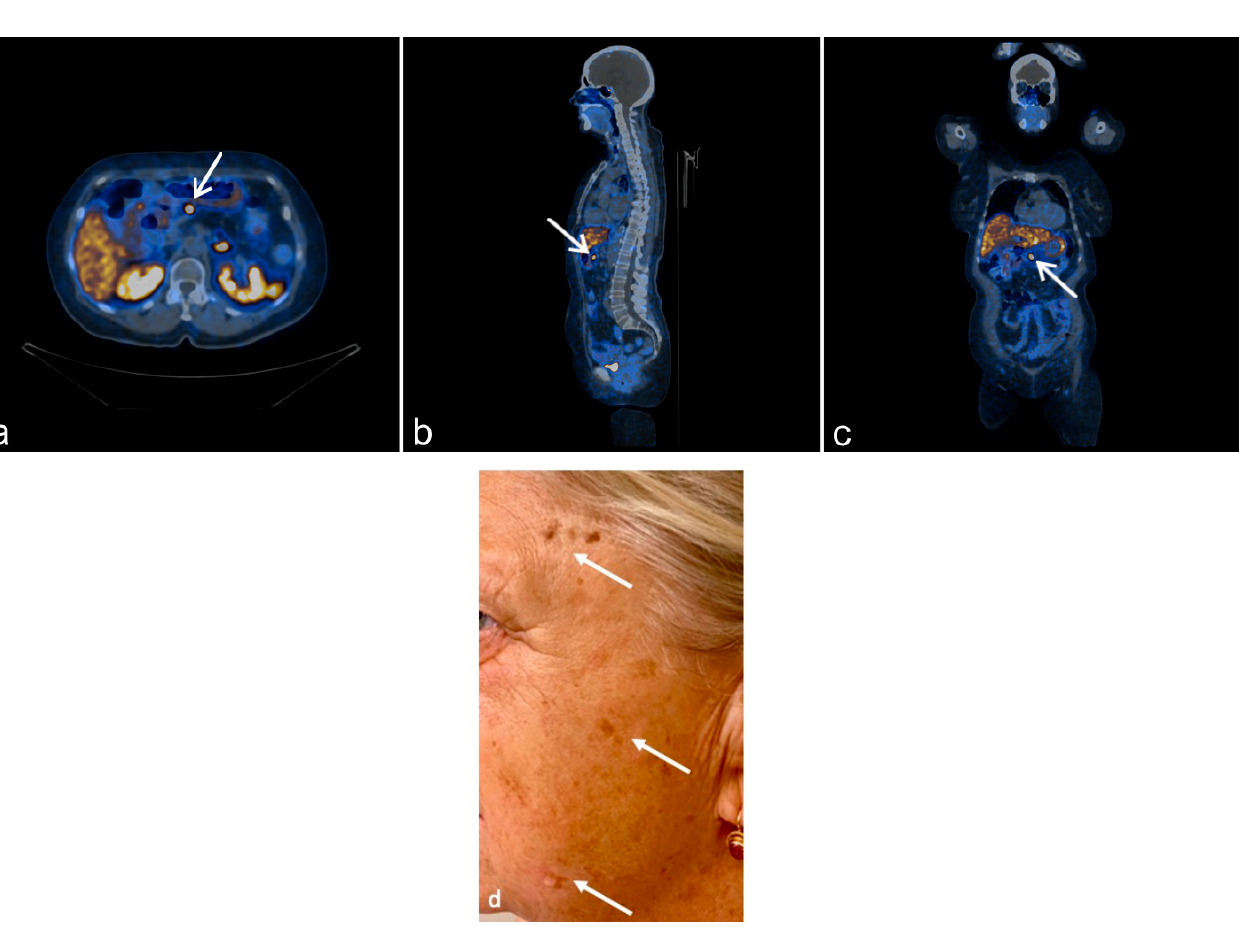
Figure 2. Clinical and radiological presentation of the index patient. Transverse ( a ), axial ( b ), and sagittal ( c ) fused ( 68 Ga) Ga-DOTATATE positron emission tomography (PET)/computed tomography (CT) images of a pancreatic insulinoma with metastases (arrows), cutaneous manifestations of MEN1 syndrome ( d ) with collagenoma, and hyperpigmented skin lesions (arrows).